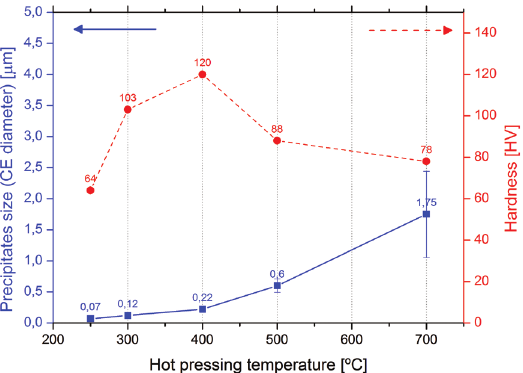
Figure 9. Plot of the relationship existing between the size of the Cu-rich precipitates ( β phase) and the hardness measured in hot pressed sterling-silver compacts (Ag-Cu alloy) at a pressure of 35MPa for 30min and at different temperatures. CE = Equivalent Circular